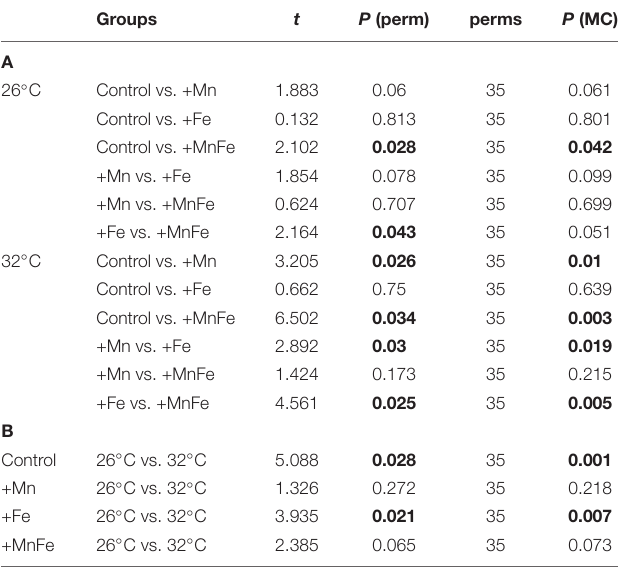
TABLE 3 | Results of the PERMANOVA pairwise comparisons between treatments at 26 ◦ C and 32 ◦ C (A), and between temperatures within each metal treatment (B) obtained by permutations (perm) for each